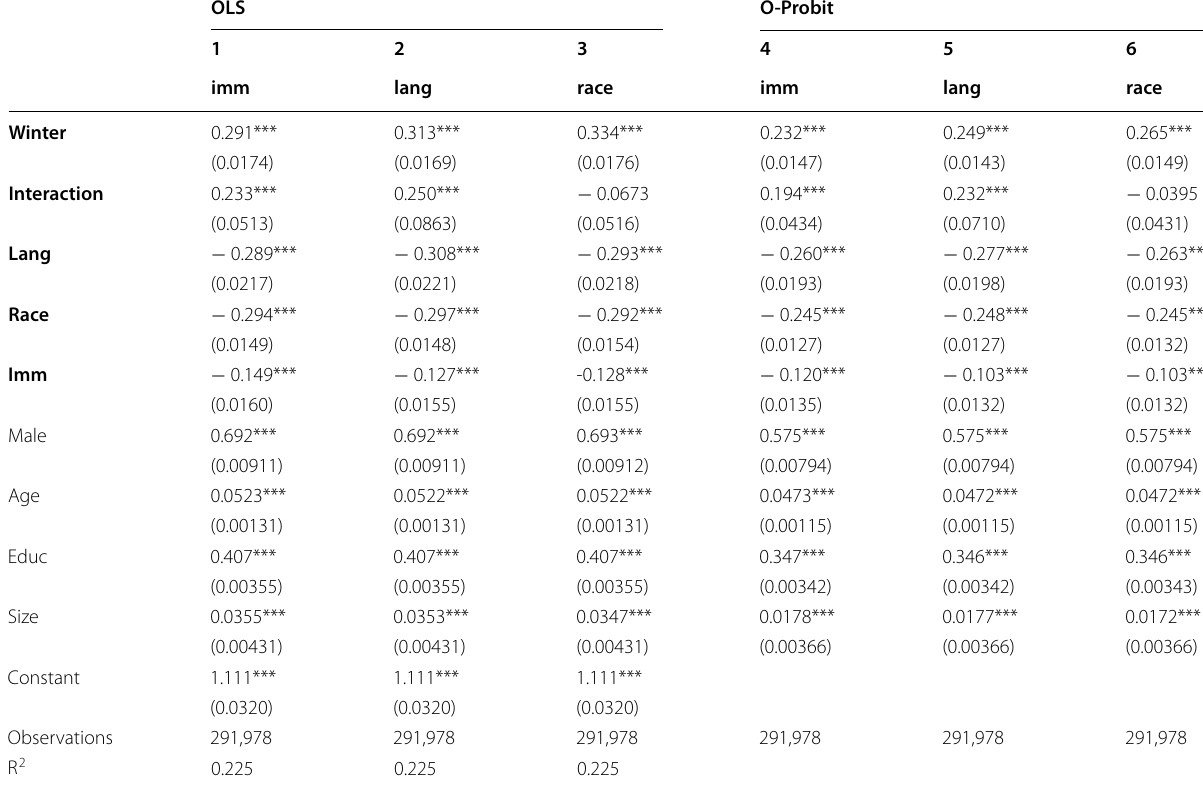
Table 4 Estimations results (base version of diff ij